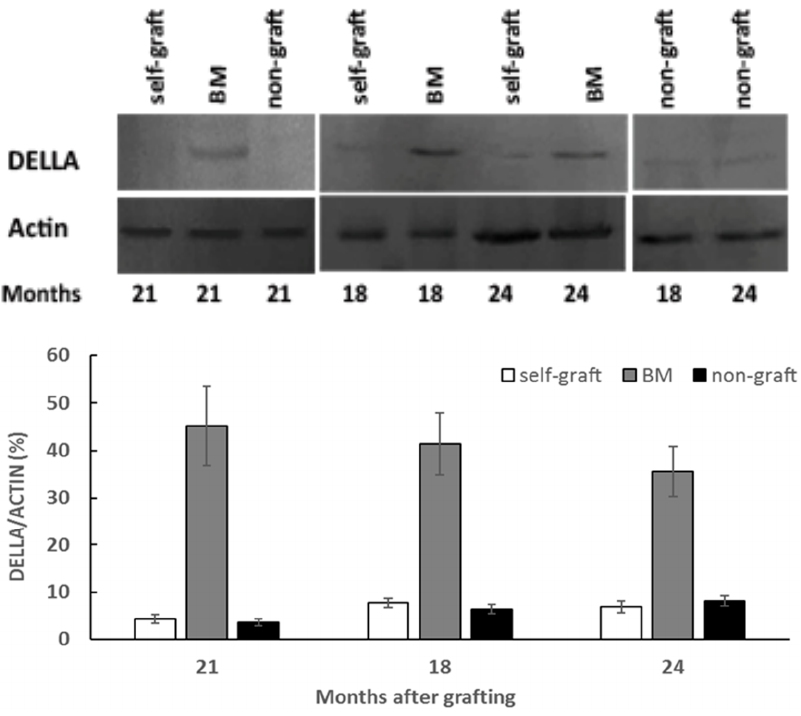
Figure 3. Analyses of DELLA protein abundance in breadfruit scion stems on different rootstocks: Total proteins were extracted from scion stems at 18, 21, and 24 months after grafting. DELLA protein abundance was determined by Western blotting with affinity-purified polyclonal anti-AaDELLA. A representative immunoblot of DELLA protein with actin as a loading control is shown on top of the histogram showing the ratio of the band intensity of the DELLA to that of the corresponding actin. BM, breadfruit plants grafted on marang rootstocks. Vertical bars represent mean ± SE derived from three biological replicates.